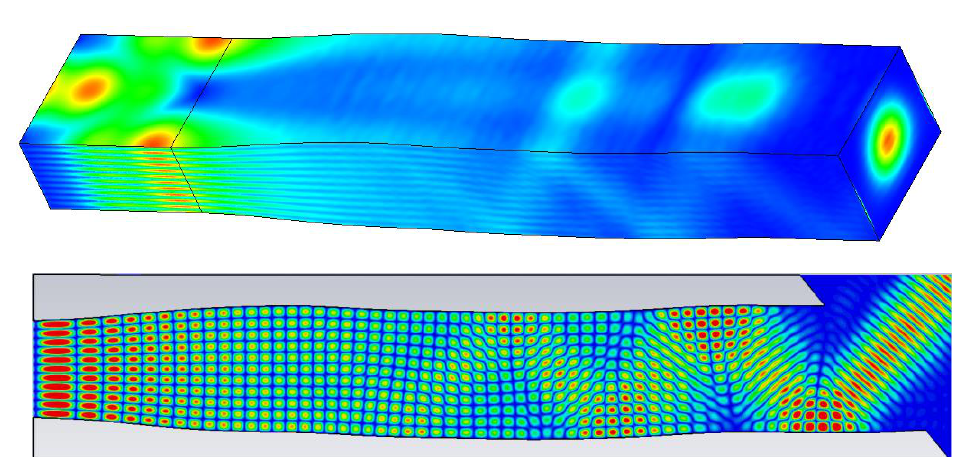
Fig. 3. Absolute value of the electric field on the walls of the synthesized waveguide converter (top) and snapshot of the electric field in its cross-section